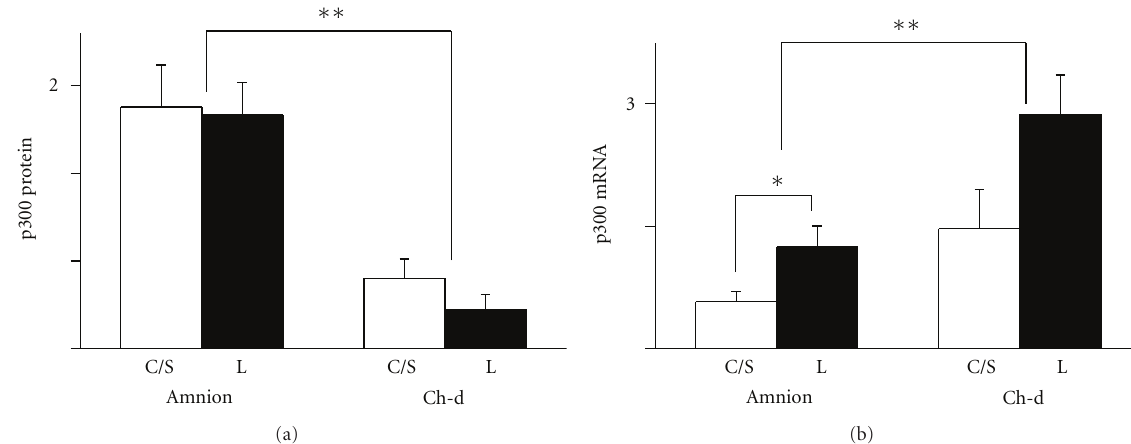
Figure 4: Expression of p300 protein (a) and mRNA (b) in the amnion and chorion-decidua (Ch-d) from non-labor group (C/S) and labor group (L). Data were presented as the mean ± SEM. (a) ∗∗ P < 0 . 05 between amnion and chorion-decidua. (b) ∗∗ P < 0 . 05 between amnion and chorion-decidua. ∗ P < 0 . 05 between C/S group and labor group within the amnion. Ponceau S staining was used as the internal control for Westerns and GAPDH mRNA as the internal control for mRNA.